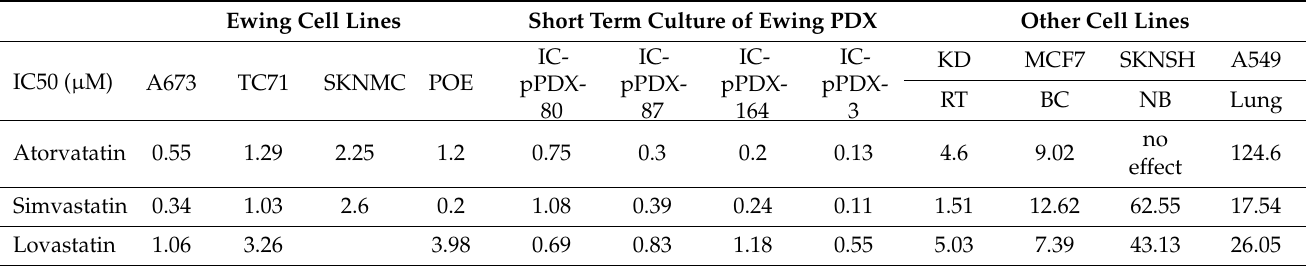
Table 1. IC50 for Atorvastatin, Simvastatin, and Lovastatin in the different Ewing cell lines. (RT: Rhabdoid Tumor, BC: Breast Cancer, NB: neuroblastoma). Short Term Culture of Ewing